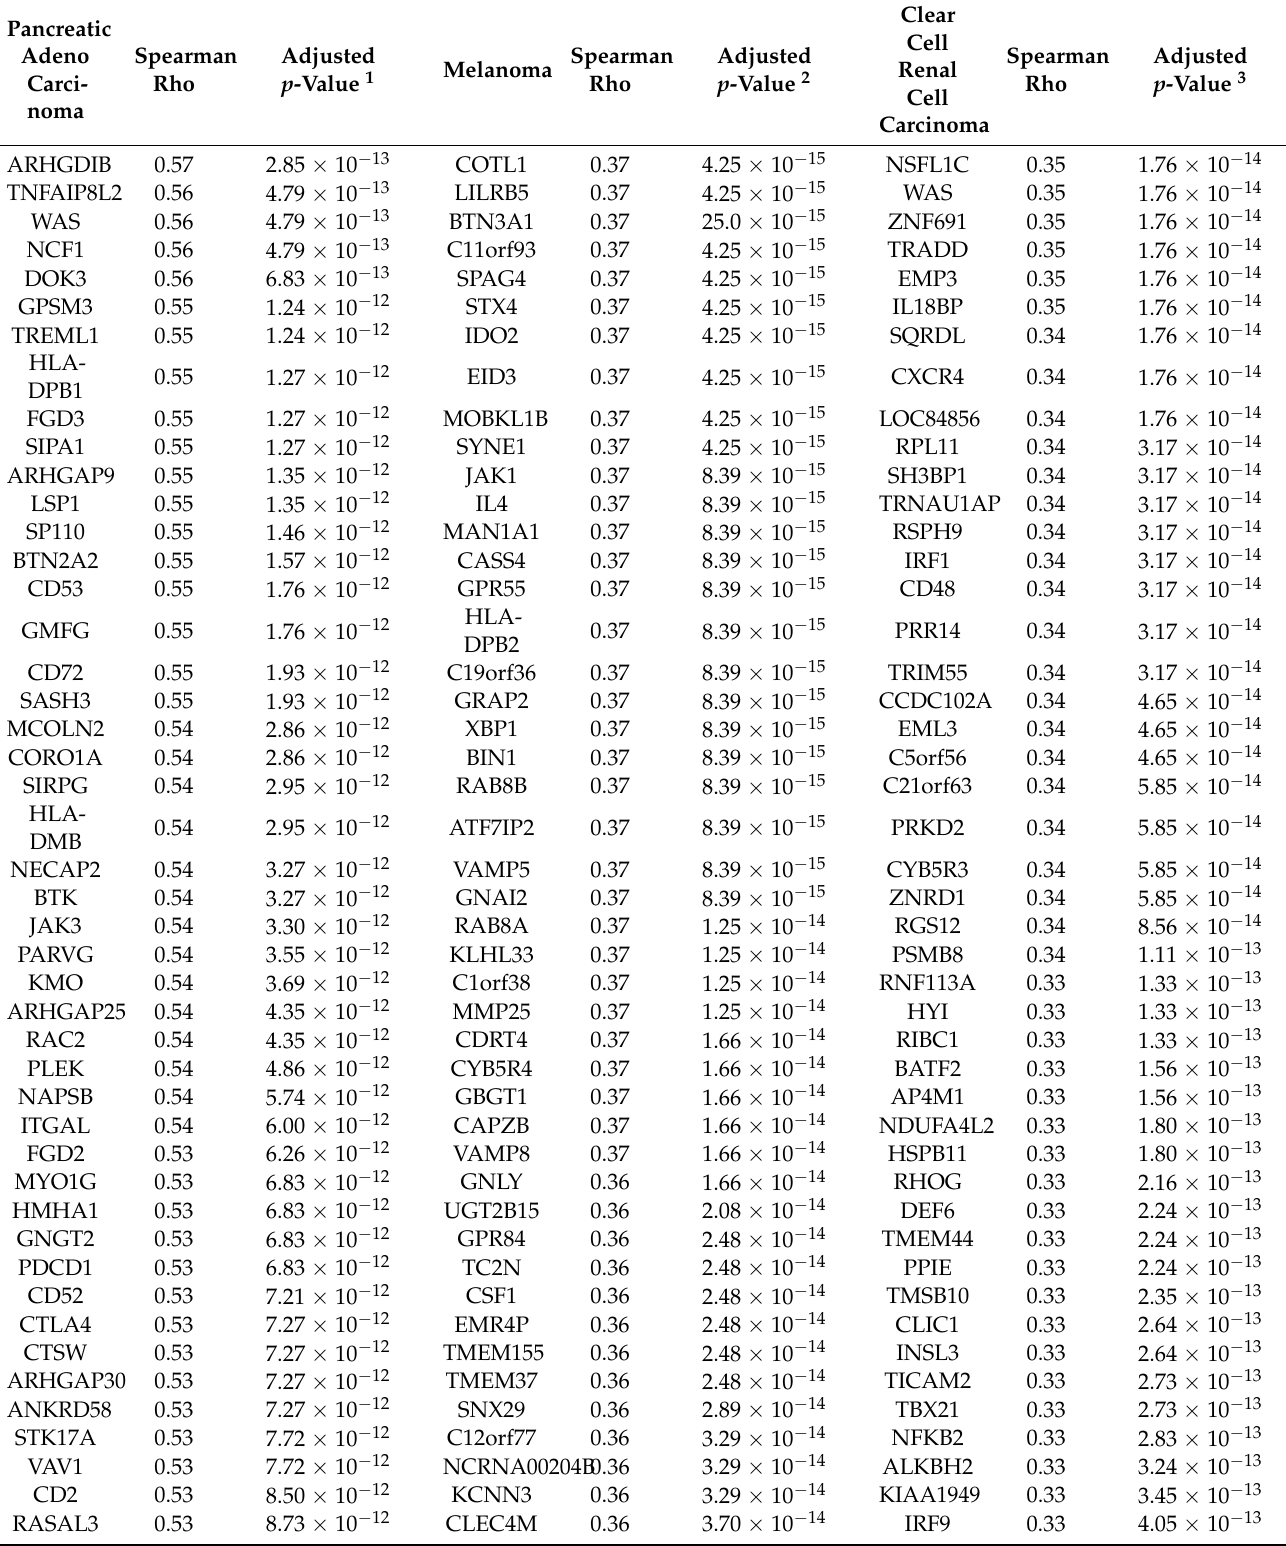
Table 1. The 50 genes with the highest correlation to CD40 in each cancer